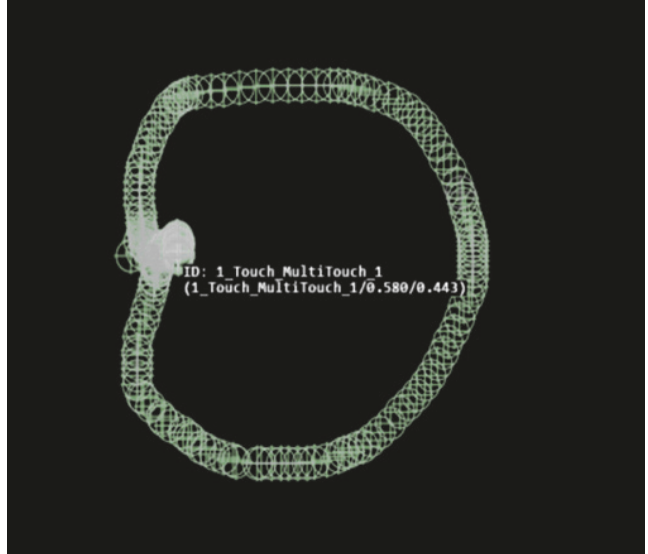
Figure 6: The computer screenshot of one-hand gesture tracking based on switching federated filter algorithm.